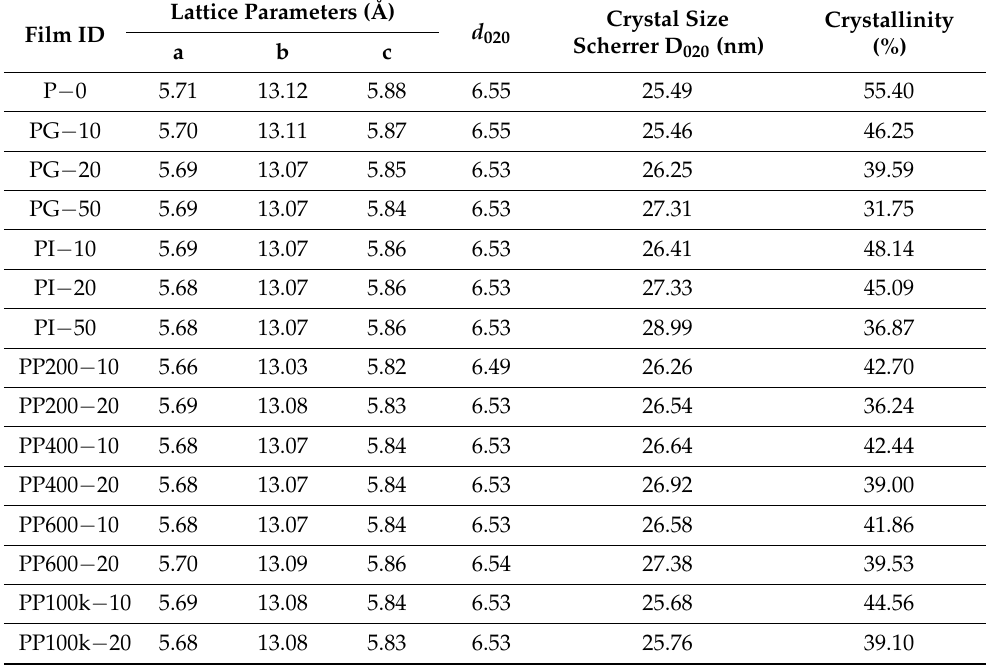
Table 4. Crystallinity parameters of the PHBH